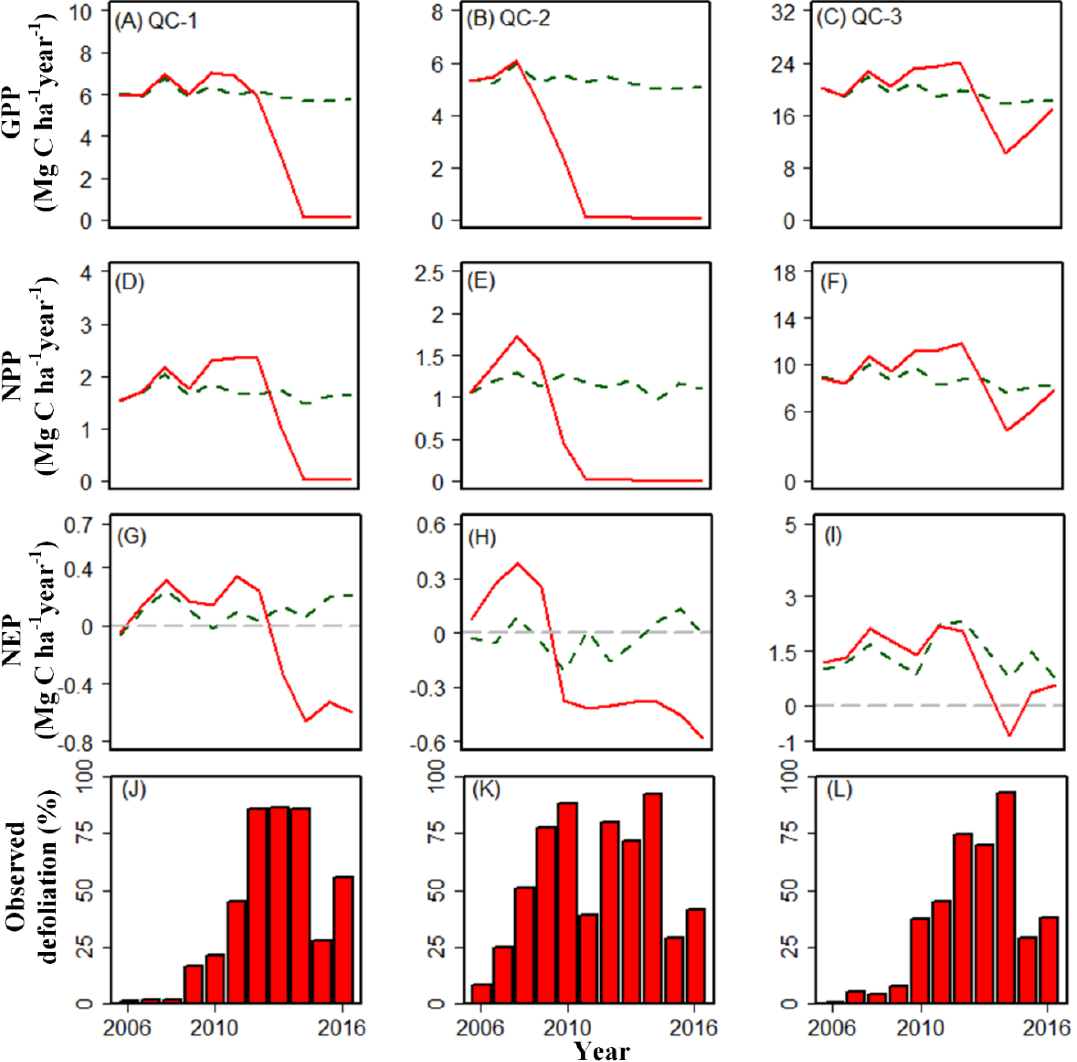
Figure 4. Simulated annual GPP, NPP, and NEP under conditions of insect disturbance (red line) and no disturbance (control; green dotted line) by the TRIPLEX-Insect model using observed annual defoliation scenarios (red bar plot) from the QC1 ( A , D , G , J ), QC2 ( B , E , H , K ), and QC3 ( C , F , I , L ) plots from 2006 to 2016.